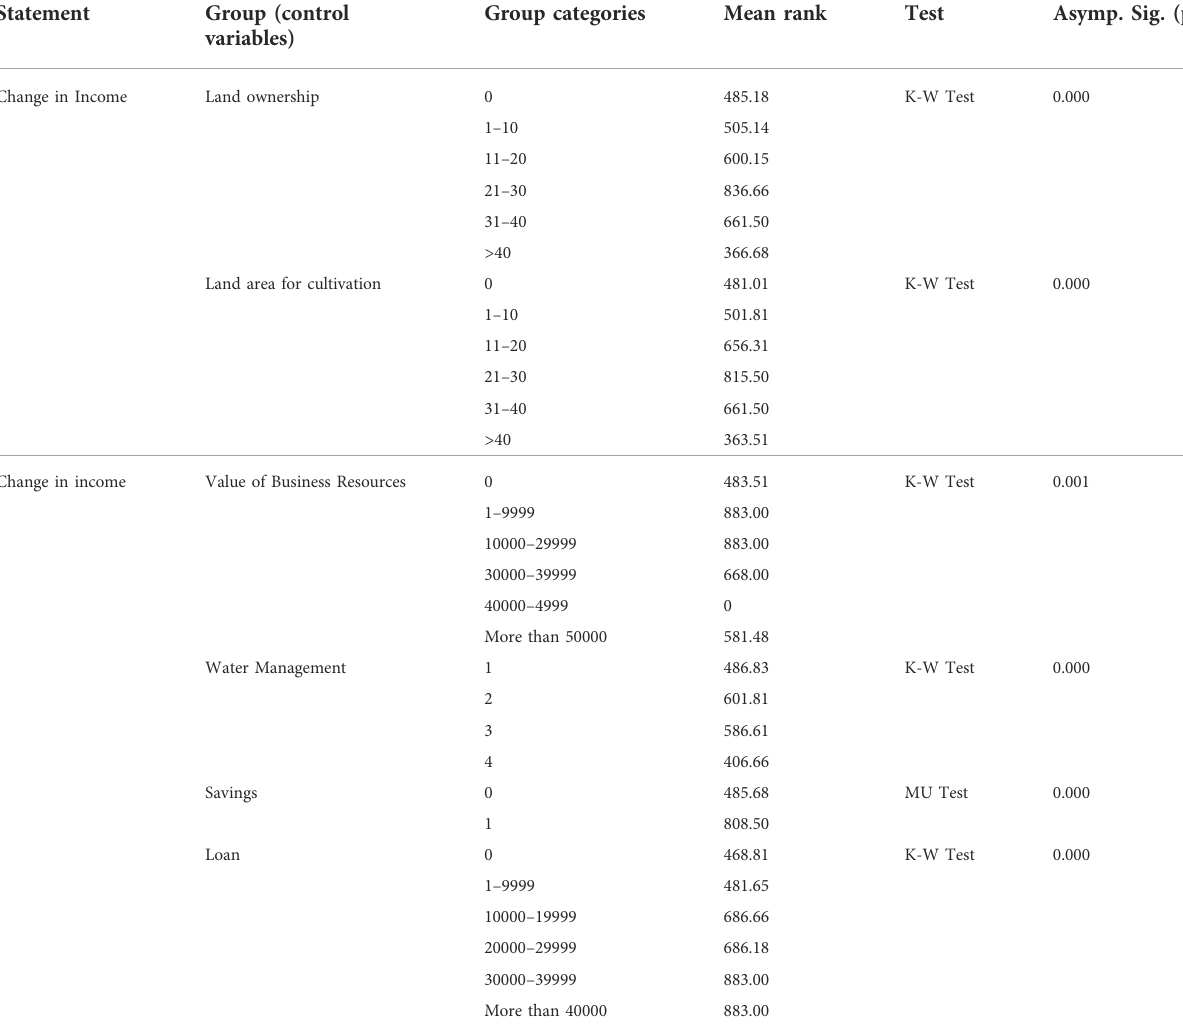
TABLE 5 Signi fi cance of land, business resources, water, saving, and loan on the income shift from the previous